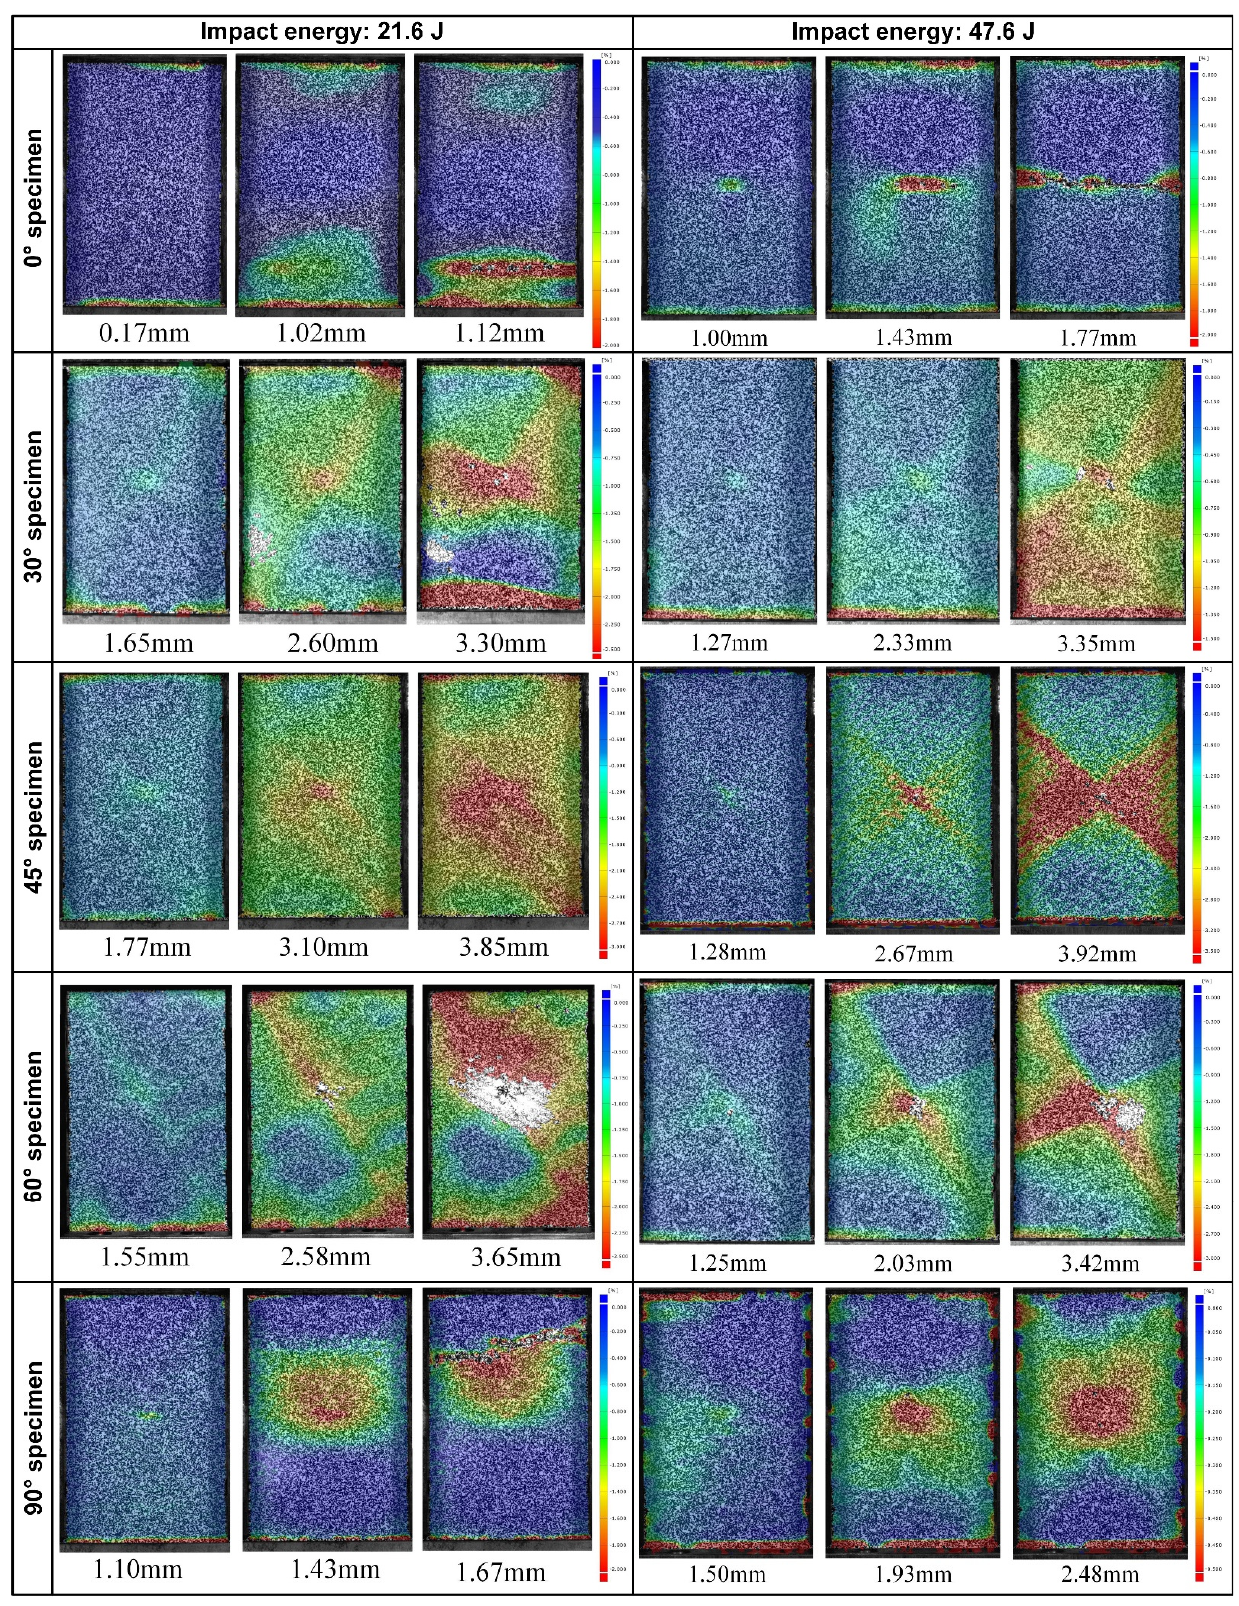
Figure 11. Full-field strain distribution on the front of the specimens under corresponding compres- sion